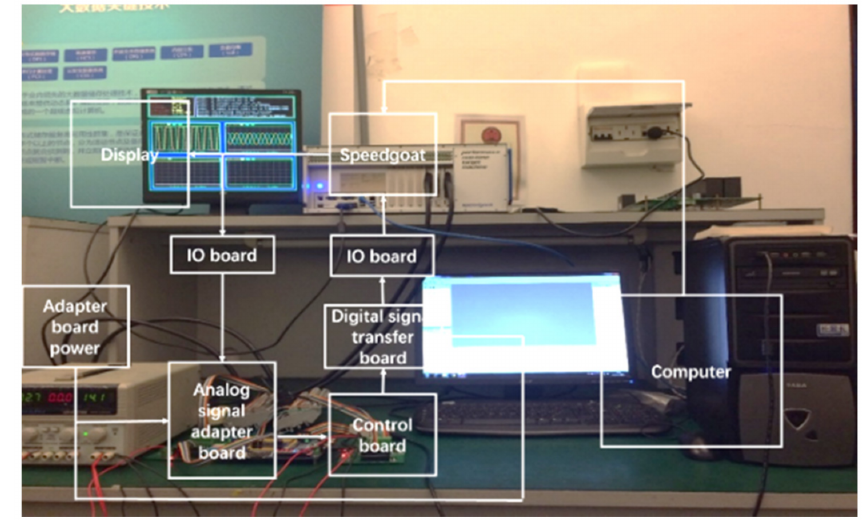
Figure 4. Hardware-in-the-loop simulation platform